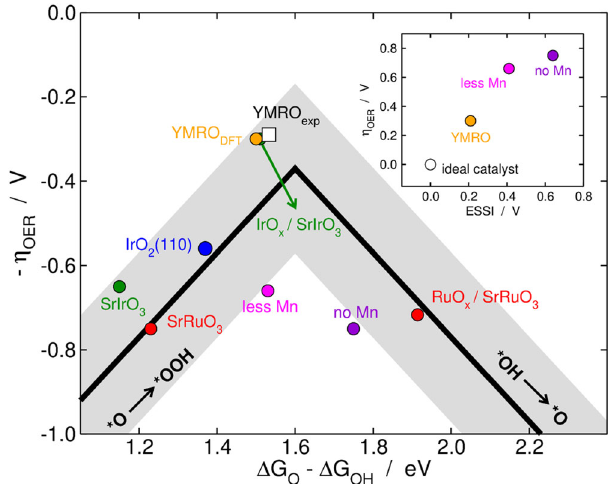
Fig. 6 | Volcano-type activity plot. OER activity in acid for a variety of oxides, including IrO